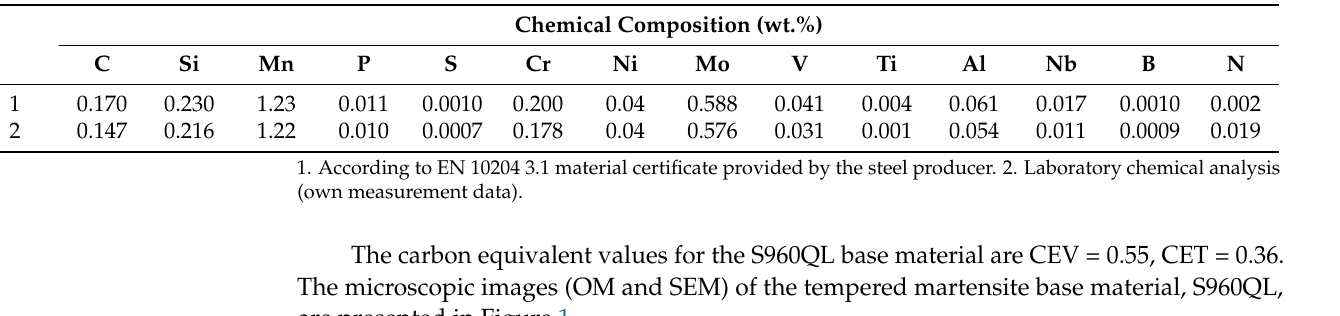
Table 1. Chemical composition of the investigated S960QL steel in wt%. Chemical Composition (wt.%)